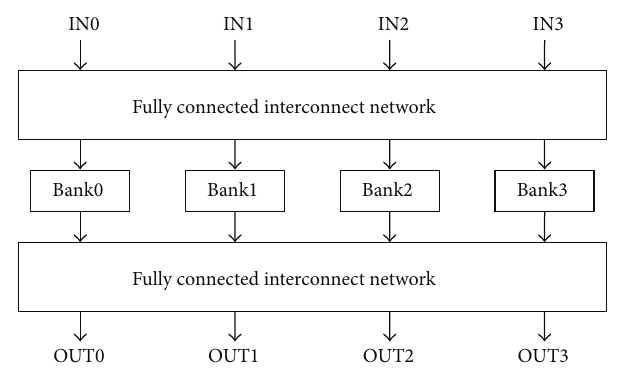
Figure 5: In the fully connected multiport memory all the buffering occurs in the fully connected interconnect